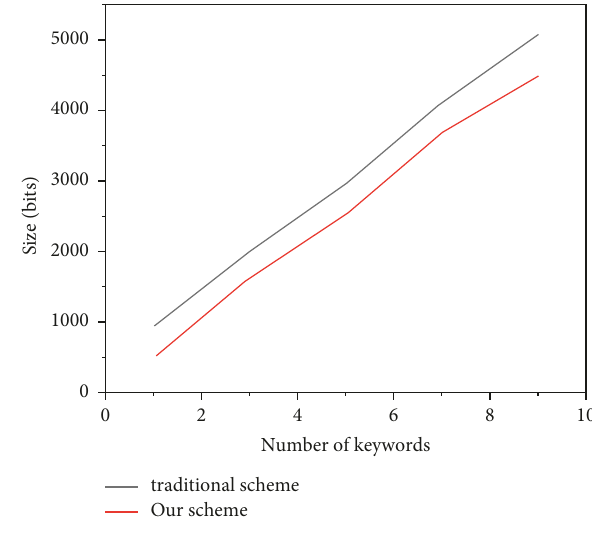
Figure 9: Time of testing algorithm.